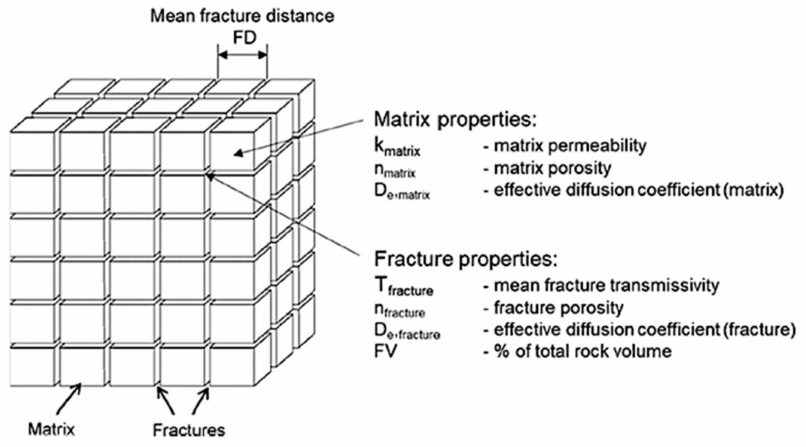
Figure 7. Illustration of the double porosity model used for the assessment of transport in fracture networks (adapted from